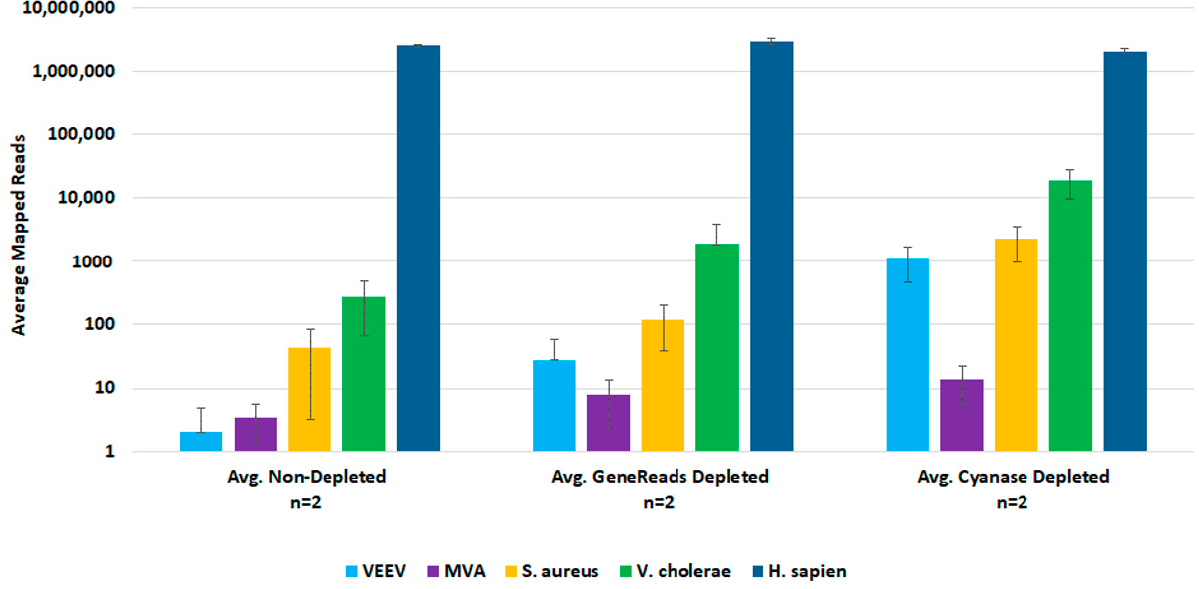
Figure 4. Comparison of Pre-lysis and Post-purification Host Depletion Methods. We evaluated both pre-lysis and post-purification host depletion methods with replicate samples. Sequencing data was analyzed in CLC Bio Genomics Workbench. The average number of mapped reads were used to evaluate target organism detection.